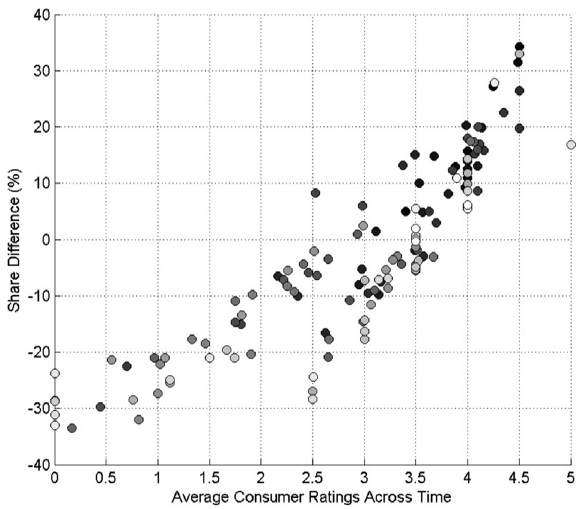
Fig. 6. Share difference for products with and without consumer reviews across